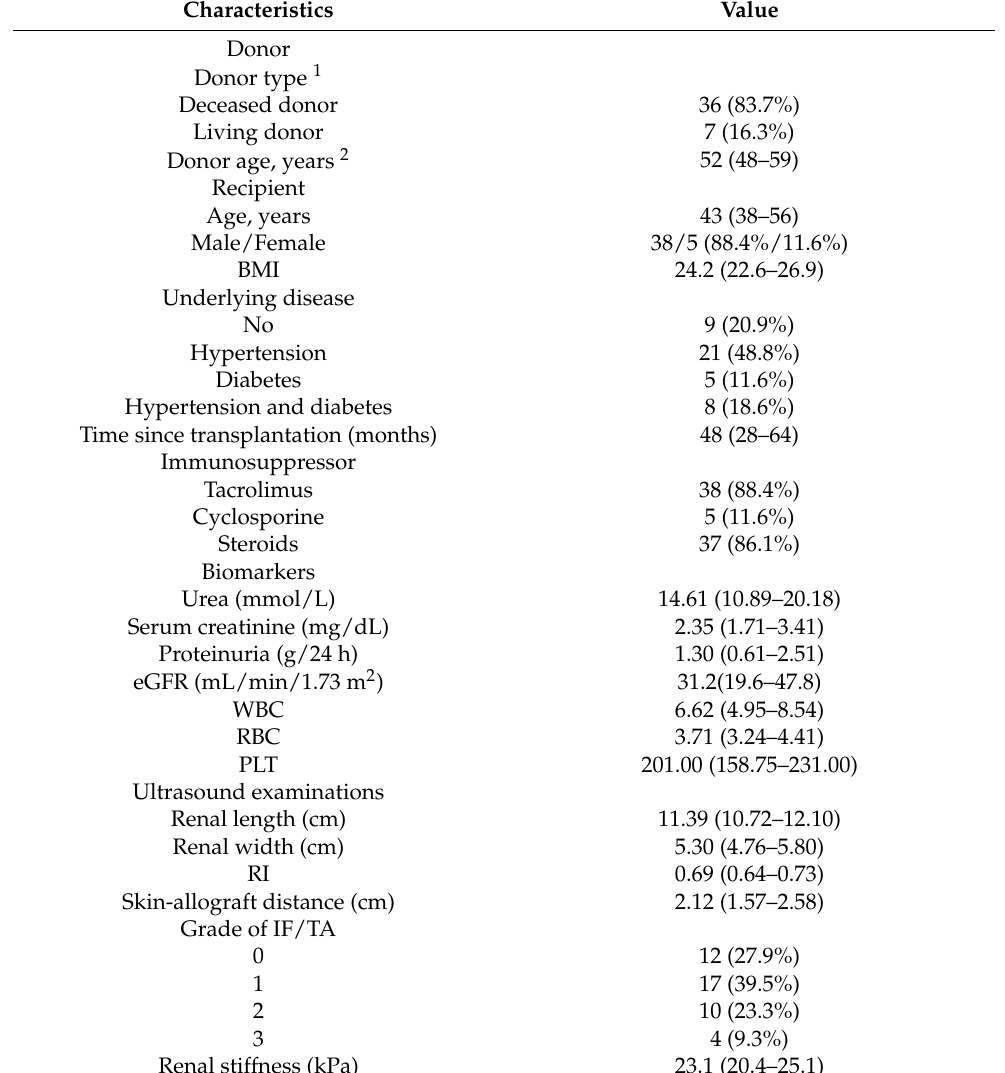
Table 1. Patients’ characteristics.